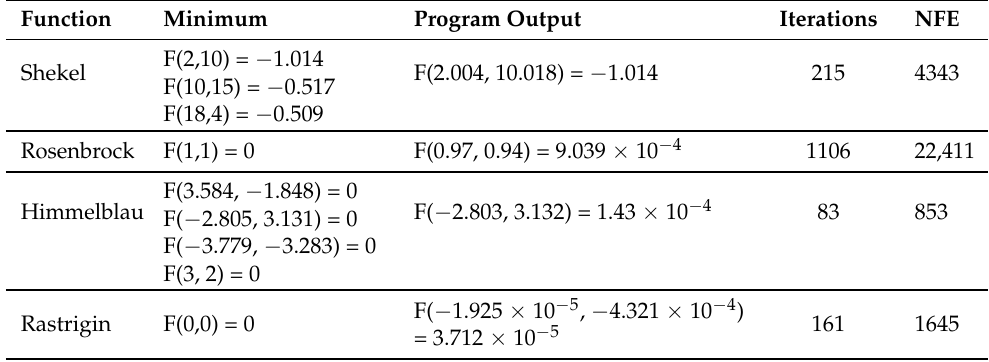
Table 4. Artificial bee colony